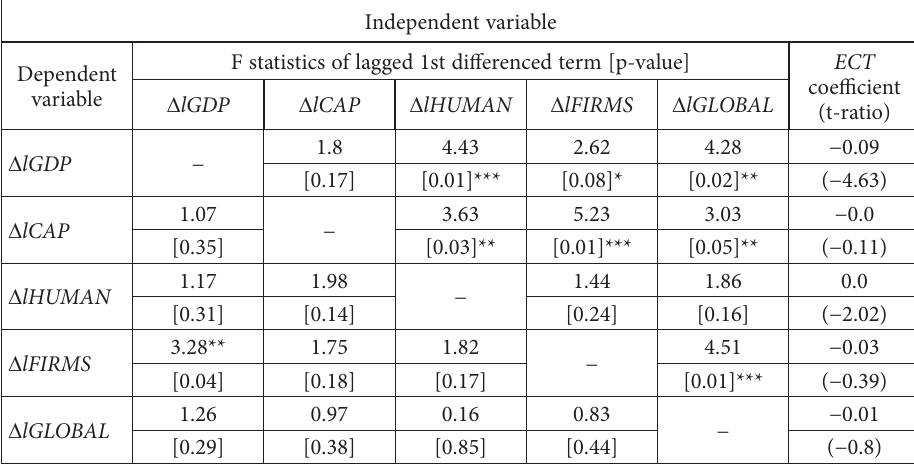
Table 5. Granger causality test results with (lFIRMS) (source: authors’ calculation) Independent